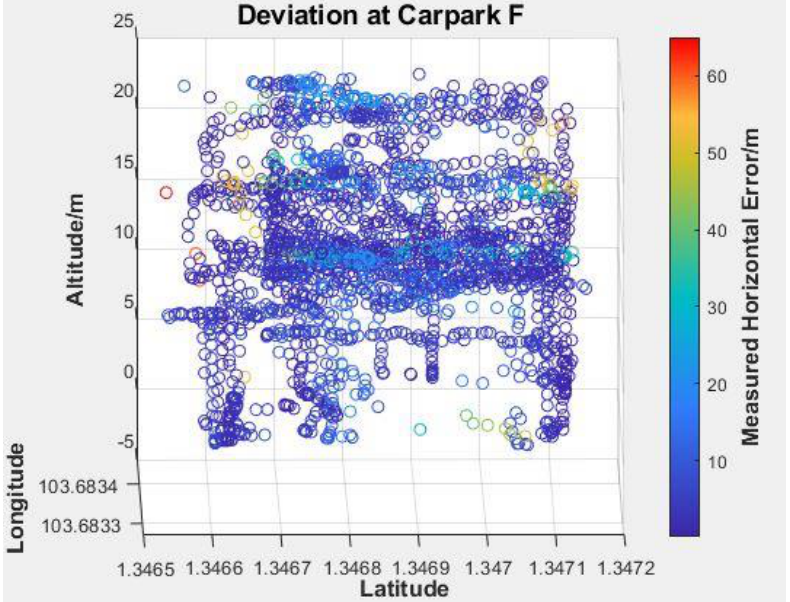
Figure 15. Position Distribution 3D Scatter Plot of Reported GPS Positions with Marker Colour Showing Markers Coloured with Measured Horizontal Error.